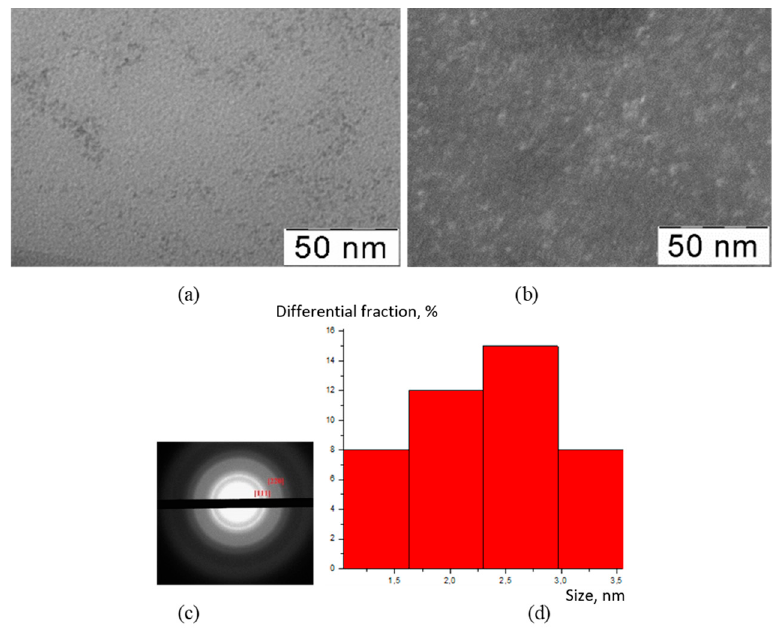
Figure 1. TEM image ( a ), TEM image in dark field ( b ), diffractogram ( c ), nanoparticle size distribution ( d ) of nanoceria-containing composites of CMC with 7.1 wt.% Ce 4+ .